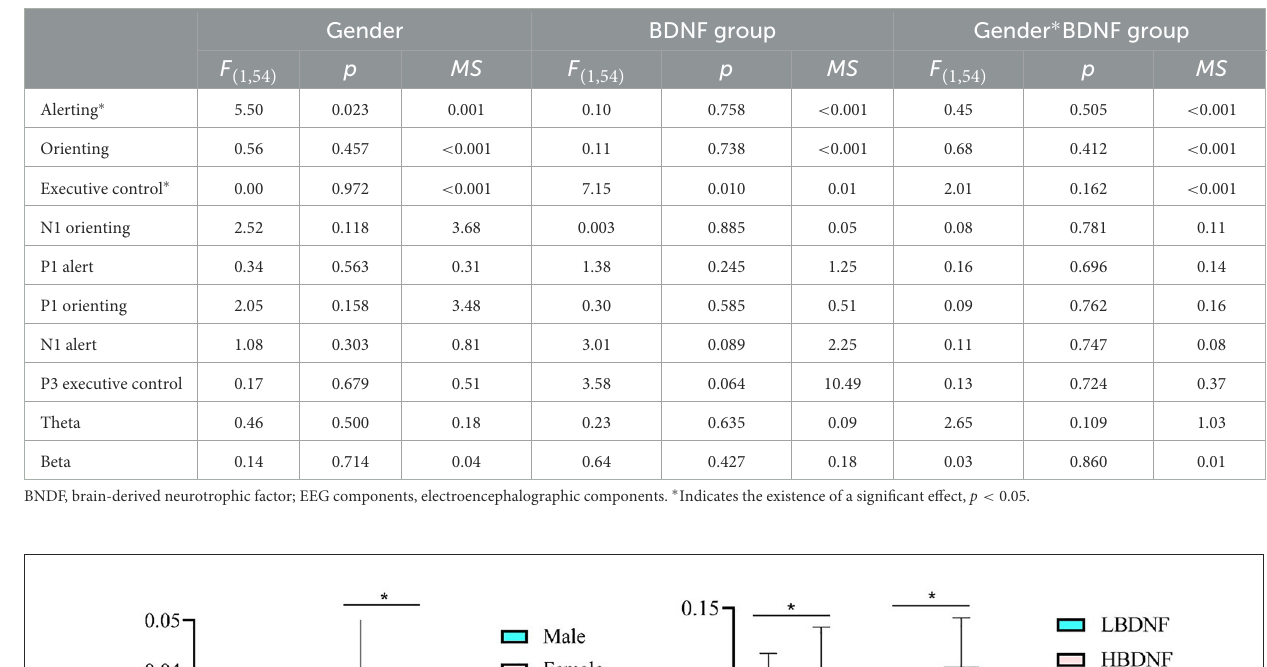
TABLE 2 Two-factor ANOVA of network/EEG component/time-frequency energy.